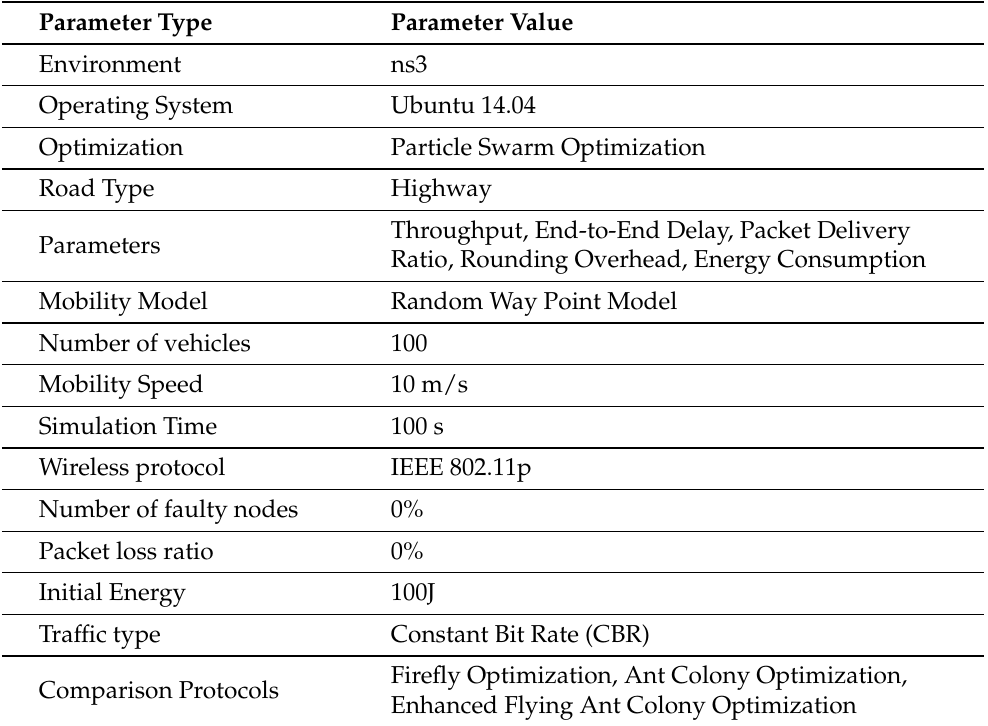
Table 1. Simulation